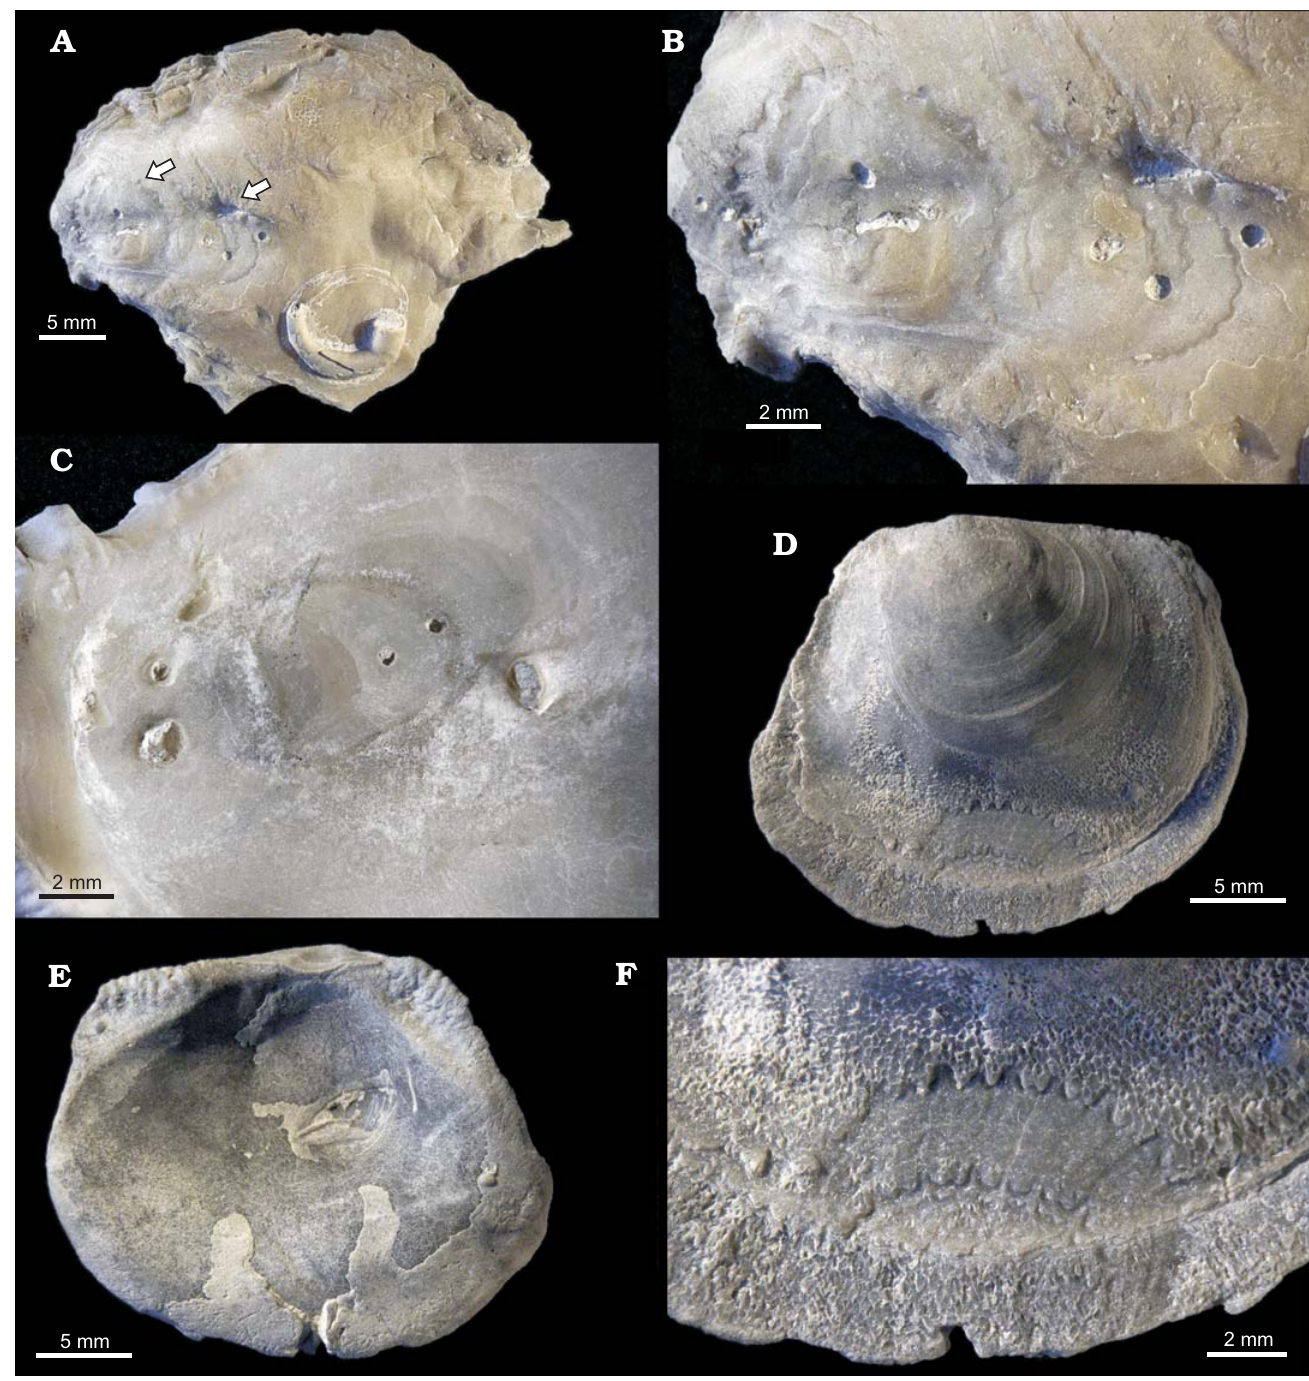
Fig. 6. Parasitic gastropod bioerosion trace Loxolenichnus stellatocinctus igen. et isp. nov., MHNLM 2015.2.346 and MHNLM 2015.2.347, paratypes; lower Campanian Inoceramus lingua–Goniotheuthis quadrata Zone , quarry near Höver, Germany. A . Outer side of an oyster valve, accommodating two specimens of L. stellatocinctus (arrows). B . Close-up of the two specimens and the multiple perforations. C . Inner side of the oyster valve showing two of the perforations reaching the adductor muscle pad. Outer ( D ) and inner ( E ) sides of an oyster valve with a marginal L. stellatocinctus. F . Close-up of D, note the two concentric stellate rims and the marginal